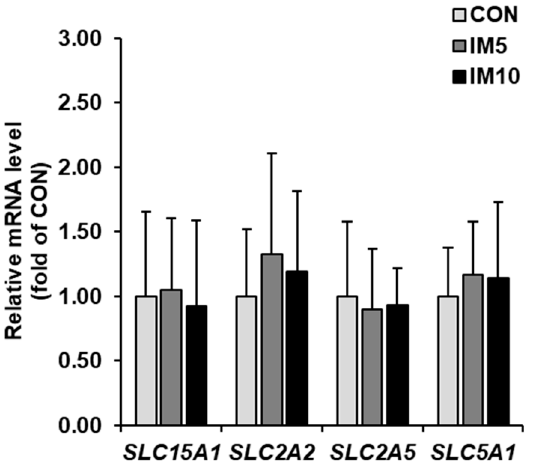
Figure 6. Relative mRNA levels of genes encoding nutrient transporters (solute carrier family 15 member 1 ( SLC15A1 ), SLC2A2 , SLC2A5 , and SLC5A1 ) in the jejunal mucosa of pigs fed isonitrogenous diets without (CON) or with 5% (IM5) or 10% Tenebrio molitor larvae meal (IM10) for four weeks. Bars are means ± SD for n = 10 pigs per group. Relative mRNA levels are expressed as the fold of group CON (= 1.0). a,b Values with different superscripts differ significantly at p < 0.05.